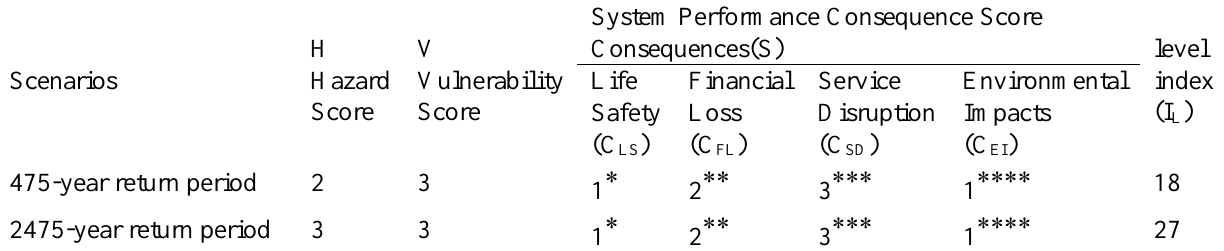
Table 7. Level index for 63 KV transmission substations of Qazvin according to ALA Scenarios